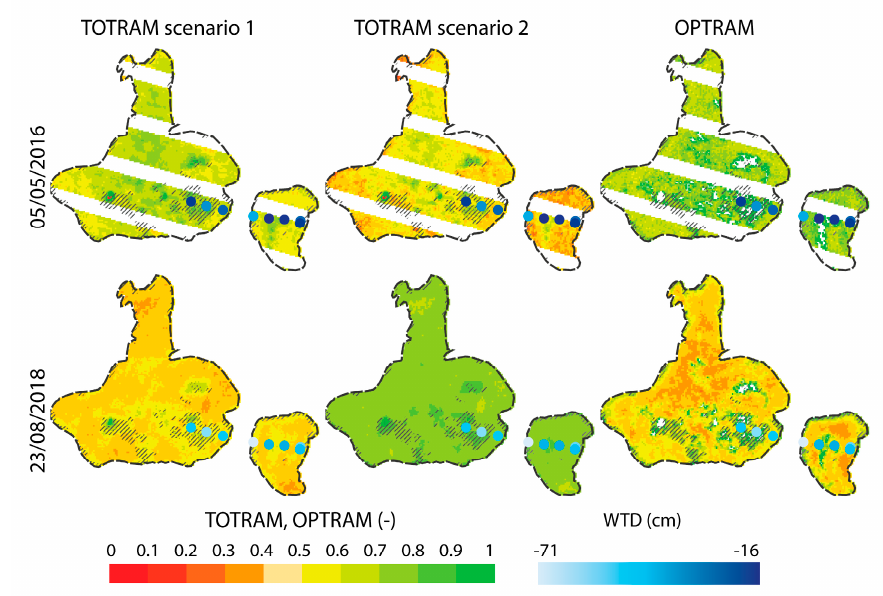
Figure 10. Maps of soil moisture index generated with TOTRAM Scenario 1, TOTRAM Scenario 2, and OPTRAM together with indicated water table depth (WTD) for each monitoring well. The white areas within the bogs represent missing data resulting from Landsat 7 Scan Line Corrector failure (striped pattern on 05 / 05 / 2016) or methodological constraints (filtering of oversaturated pixels in OPTRAM). The black hatched pattern indicates the treed bog